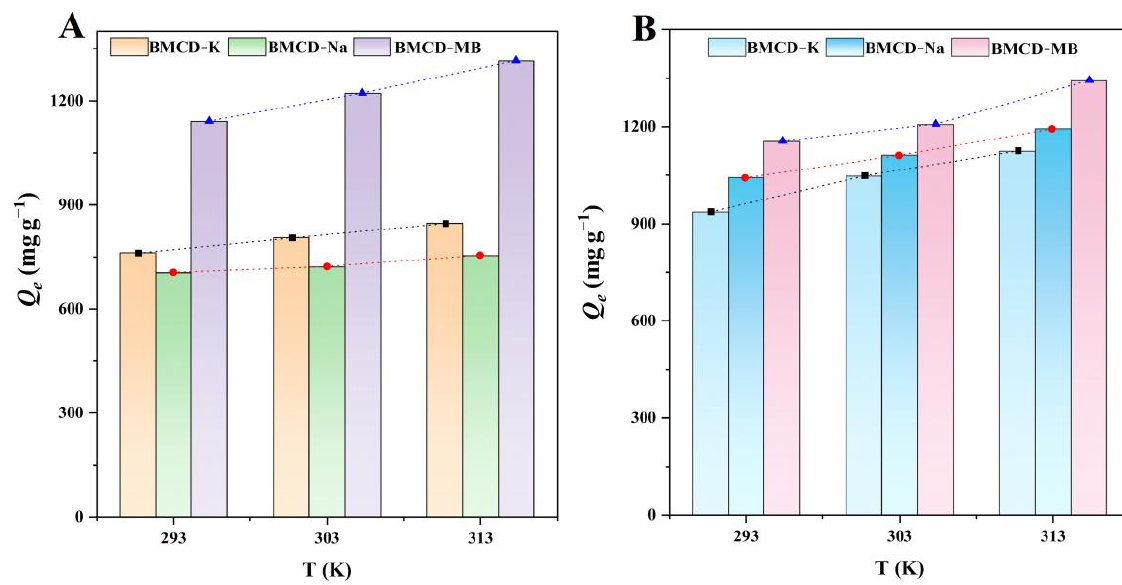
Figure 8. The adsorption thermodynamics of BMCD-K, BMCD-Na, and BMCD-MB for ( A ) RhB and ( B ) TH.